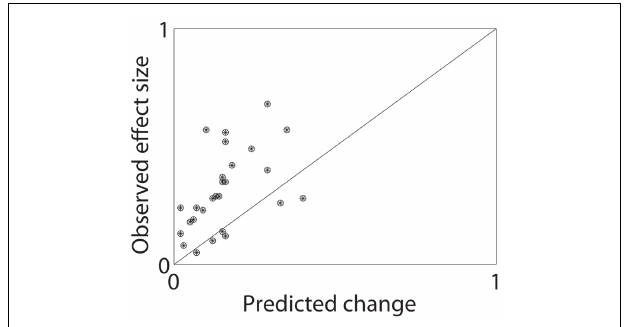
FIGURE 2 | Predicted and observed effect sizes of contingency management processes . From the meta-analysis by Lussier et al. (36), we calculated the expected change in demand by applying the contingent alternate reward (in $) to the average demand curve found by Bruner and Johnson (21). This gave a predicted effect size, which was dramatically less than the typical effects observed. See text for additional